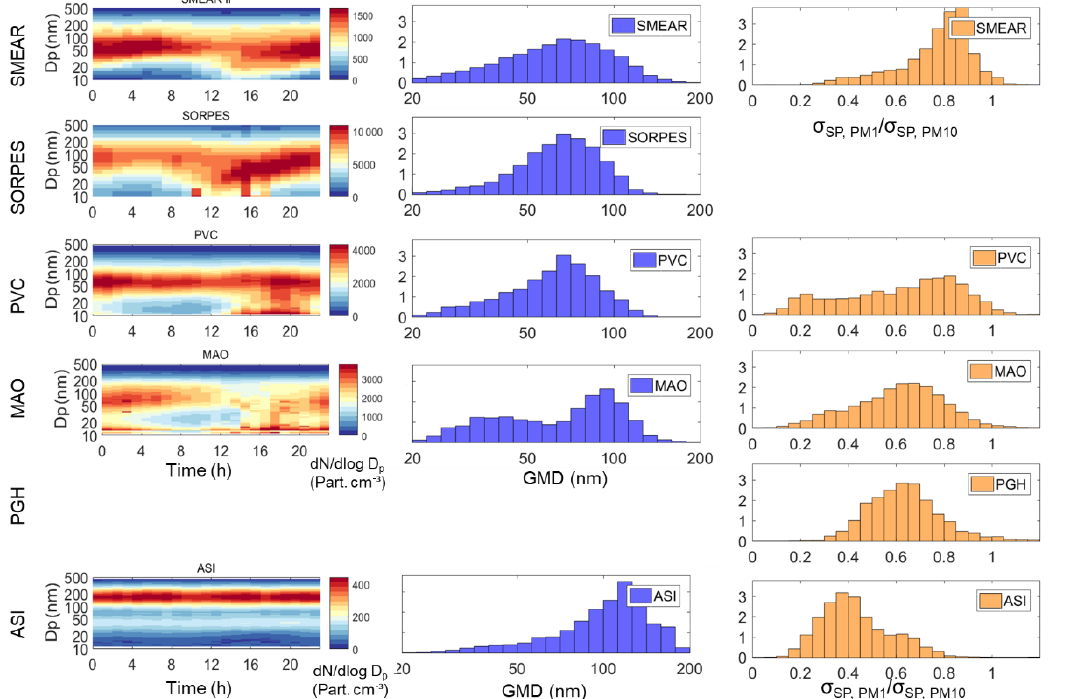
Figure 13. Analyses of particle size distributions at the six sites. (a) Average diurnal cycle of PNSD and (b) normalized size distribution of GMD at SMEAR II, SORPES, PVC, and ASI; (c) normalized frequency distribution of σ sp (PM 1 ) /σ sp (PM 10 ) at SMEAR II, PVC, MAO, PGH, and